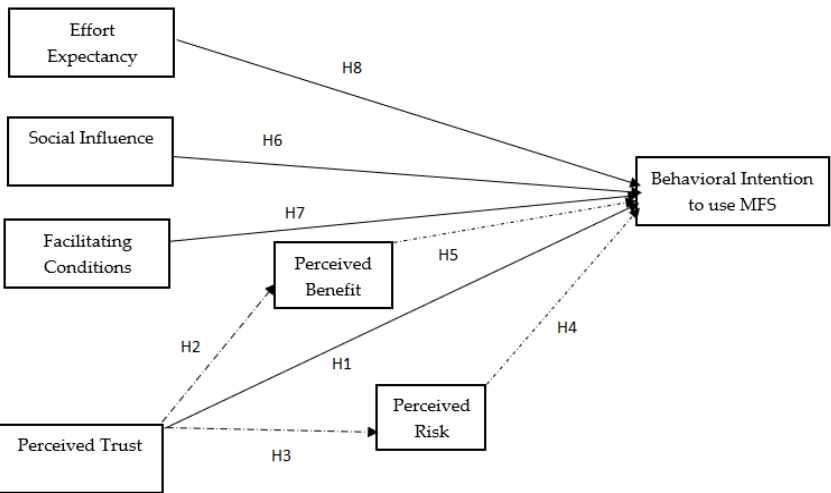
Figure 1. Research framework.